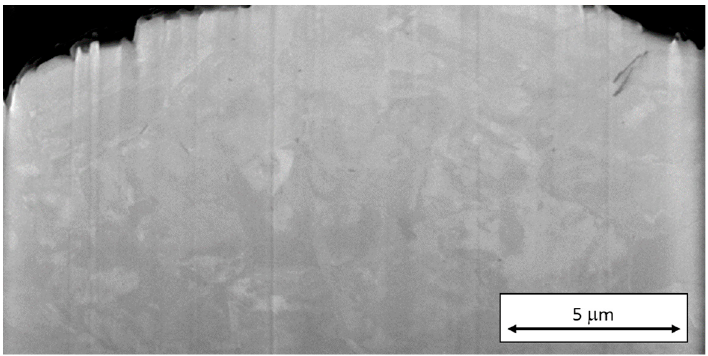
Figure 5. A crack below the surface of a virgin powder particle in a scanning electron micrograph taken during FIB milling. The inner structure of the particle has already been partially revealed by etching with the ion beam.